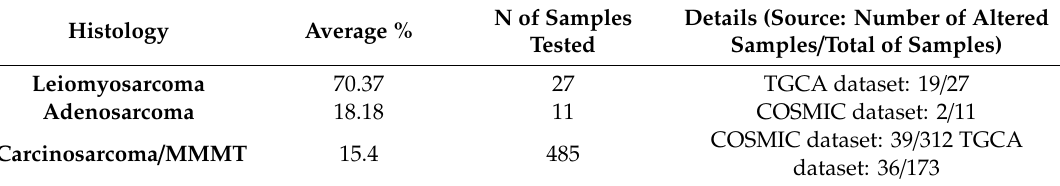
Table 5. Incidence of PTEN alterations in uterine cancers * according to histotypes.